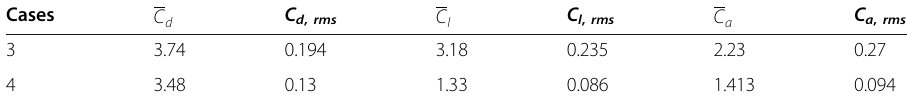
Table 4 Comparison of local drag and lift coefficients of the rotating Magnus rotor with different aspect ratios